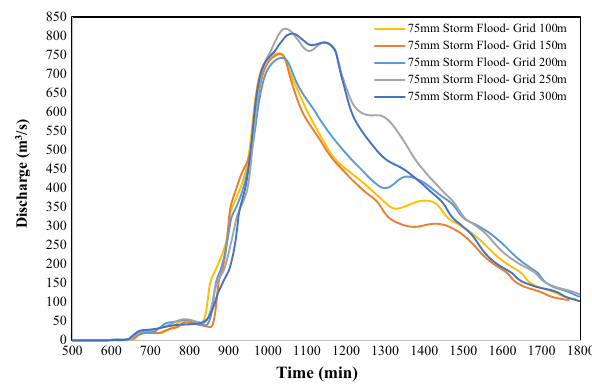
Fig. 22 Flood properties of calibrated GSSHA base model for a 24-h, 75 mm storm flood compared to hydrographs corresponding to GSSHA models with cell sizes of 100–300 m